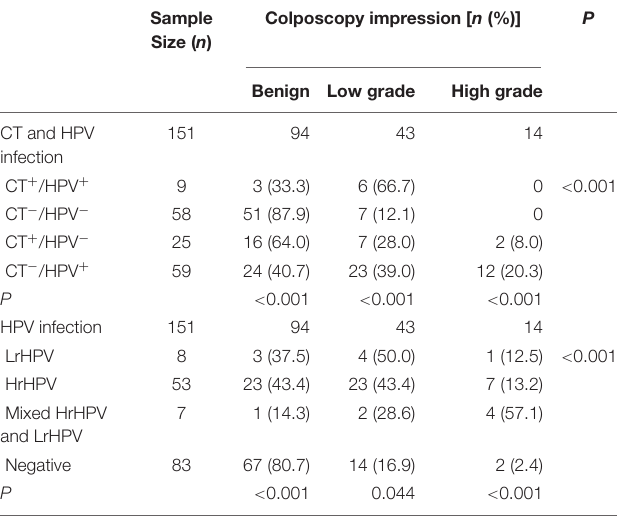
TABLE 5 | Cytology-associated C. trachomatis and HPV infection among 151 Cases. Sample Colposcopy impression [ n Size ( n )